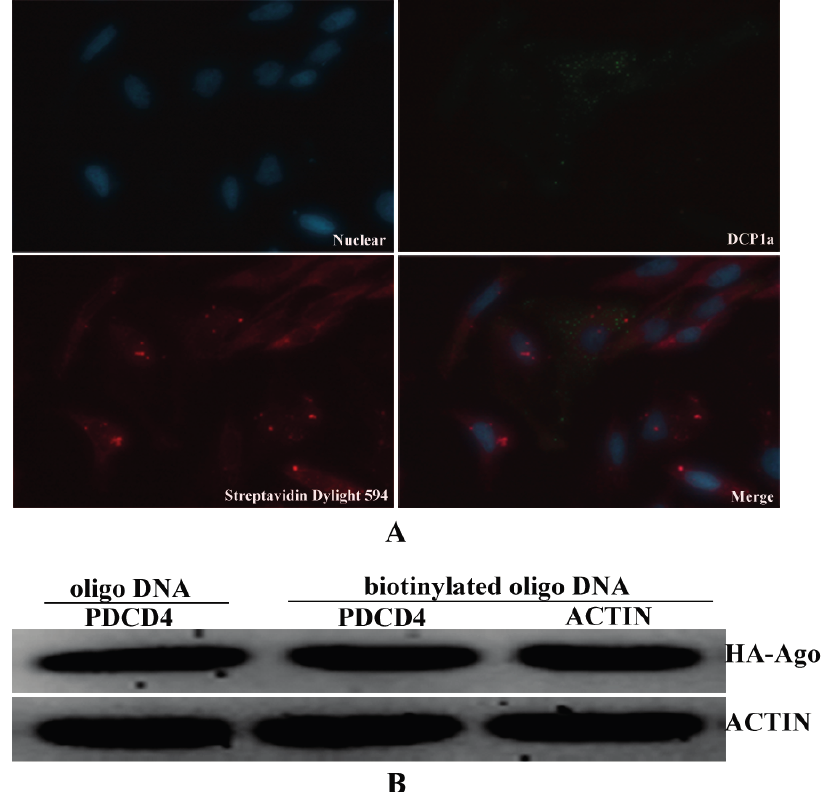
Figure 4. Over-expression of Argonaute 2 protein is to increasing the bingding force between miRNA and mRNA. ( A ) Biotinylated oligo DNA were not localization with P-body in cells; and ( B ) Flag/HA-Ago 2 were detected in the extracts of cells that transfected with Flag/HA-Ago 2